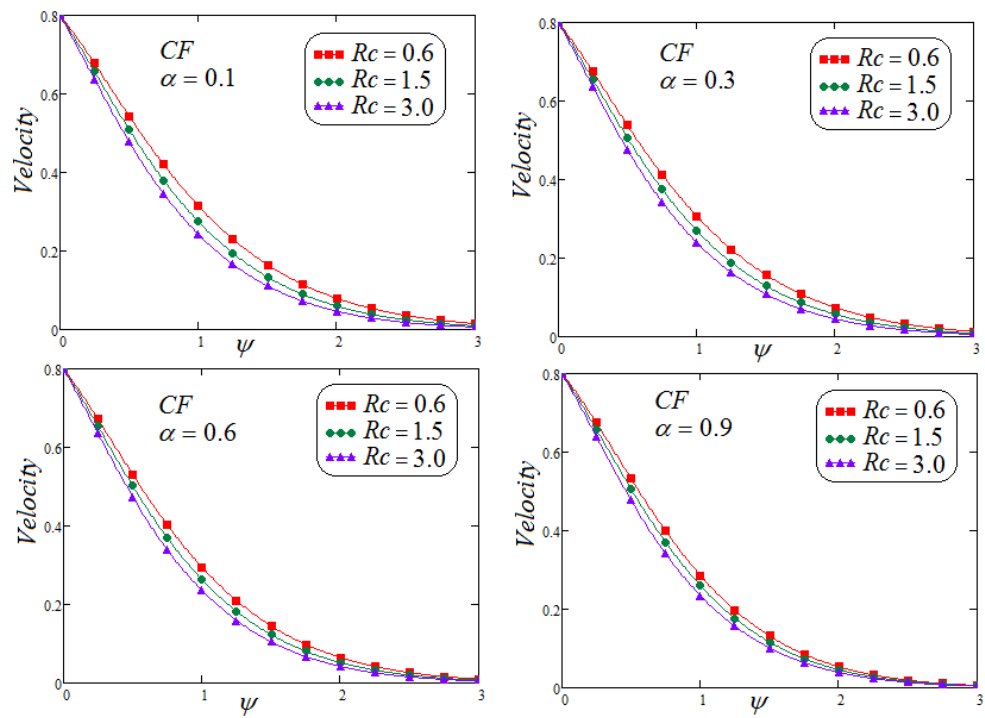
Figure 9. Trace of dimensionless velocity for dissimilar values of R c via CF.